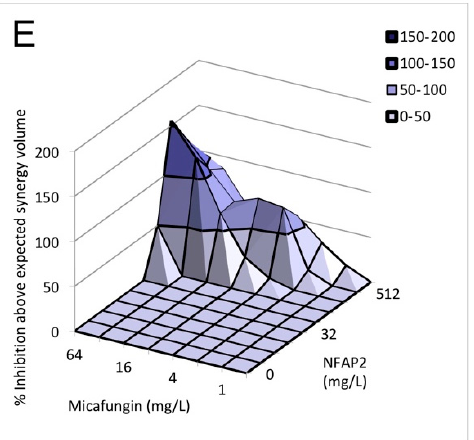
Figure 1. Effect of NFAP2 in combination with fluconazole ( A ), amphotericin B ( B ), anidulafungin ( C ), caspofungin ( D ) and micafungin ( E ) against C. auris isolates using MacSynergy II analysis. Additive interactions appear as a horizontal plane at 0% inhibition. The interaction is defined as synergistic if the observed surface is greater compared to the predicted additive surface. The volumes are calculated at the 95% confidence interval. The figures represent the cumulative synergy volume of five tested isolates. In panel E, higher synergy was observed; therefore, the scale of the z axis is different than in panels ( A – D ). Each figure presents the cumulative values of the five tested C. auris isolates.